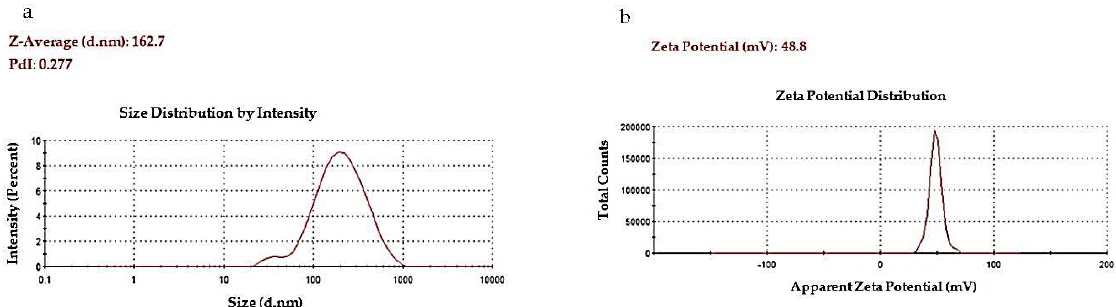
Figure 2. Physical properties of Chit-AntBiop-NPs; ( a ) particle size and pdi, ( b ) zeta potential.